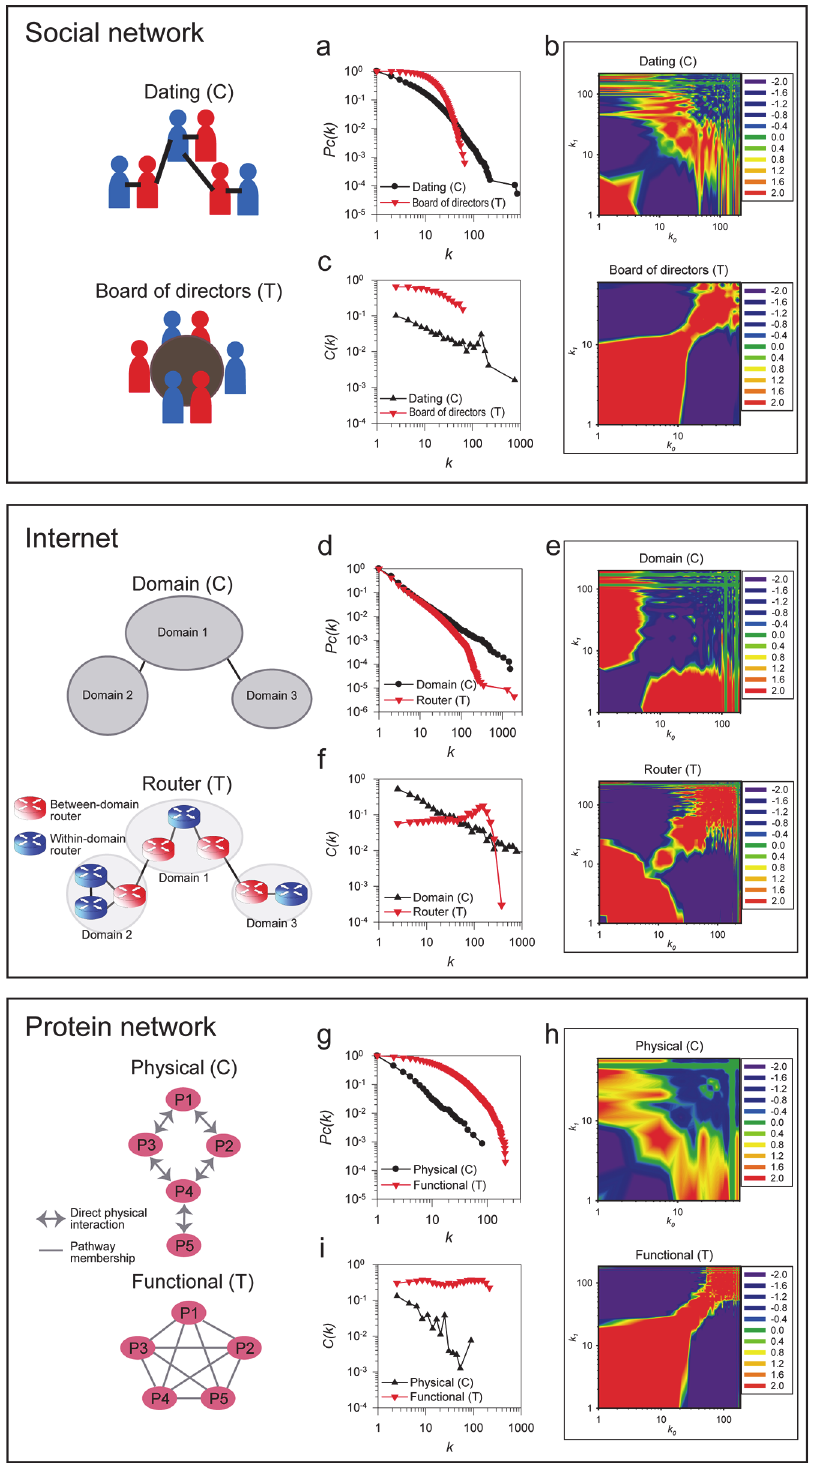
Fig 2. Dichotomy of real-world networks. Topological analysis of three real world networks ( S1 Table ). We analyzed contact-centric networks (indicated by the letter C) and task-centric networks (indicated by the letter T) for their (a, d, g) degree distribution, (b, e, h) assortativity, and (c, f, i) hierarchical structure. We tested two different human social networks, a contact-centric online dating network (Dating) [14] and a